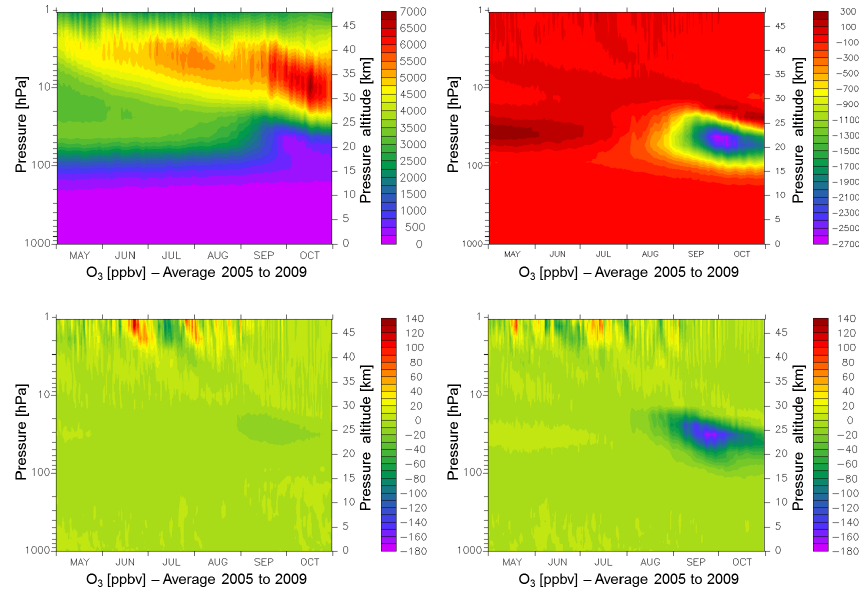
Figure 5. Ozone depletion – time series of O 3 in ppbv in the standard EMAC simulation during Antarctic winter and spring averaged over 80 ◦ to 90 ◦ S and the years 2005 to 2009 (top left) and contribution of liquid particles (top right), additional NAT particles (bottom left) and additional ice particles (bottom right). Note that the colour bars have different units.